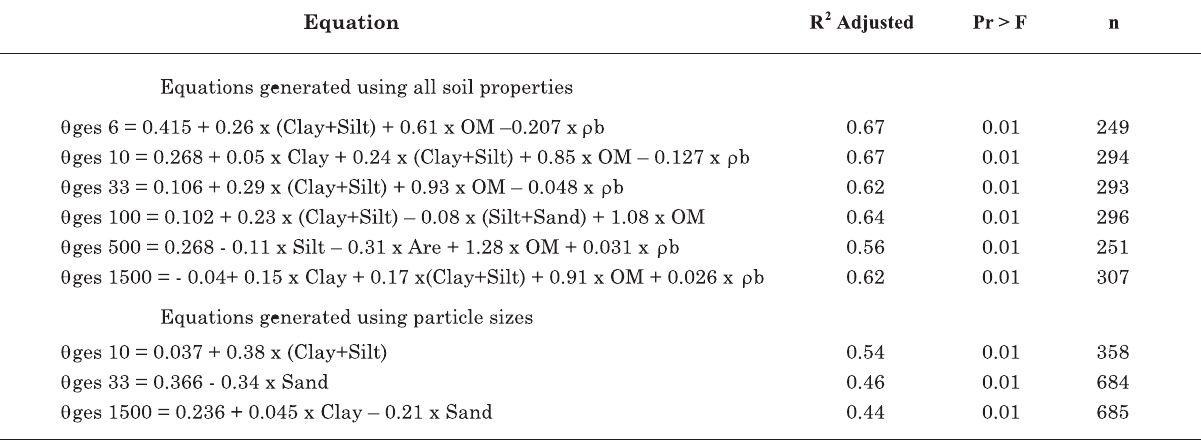
Table 4. Pedofunctions generated to estimate the gravimetric soil water content (kg kg -1 ) from data of Rio Grande do Sul soils, with all soil properties for the tensions of 6, 10, 33, 100, 500 and 1,500 kPa and